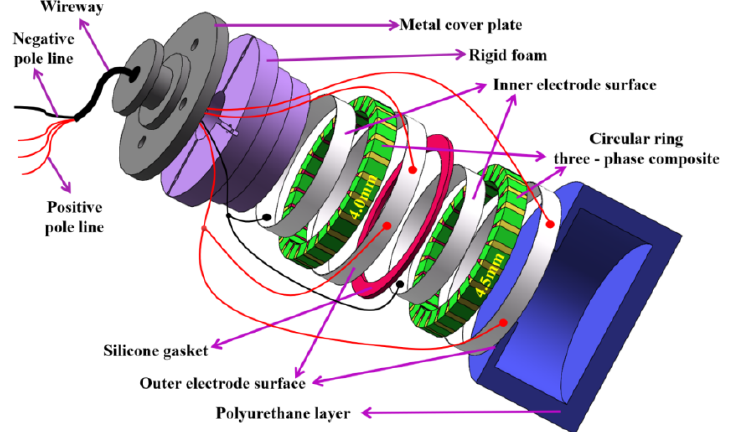
Figure 12. Structure of the array transducer.